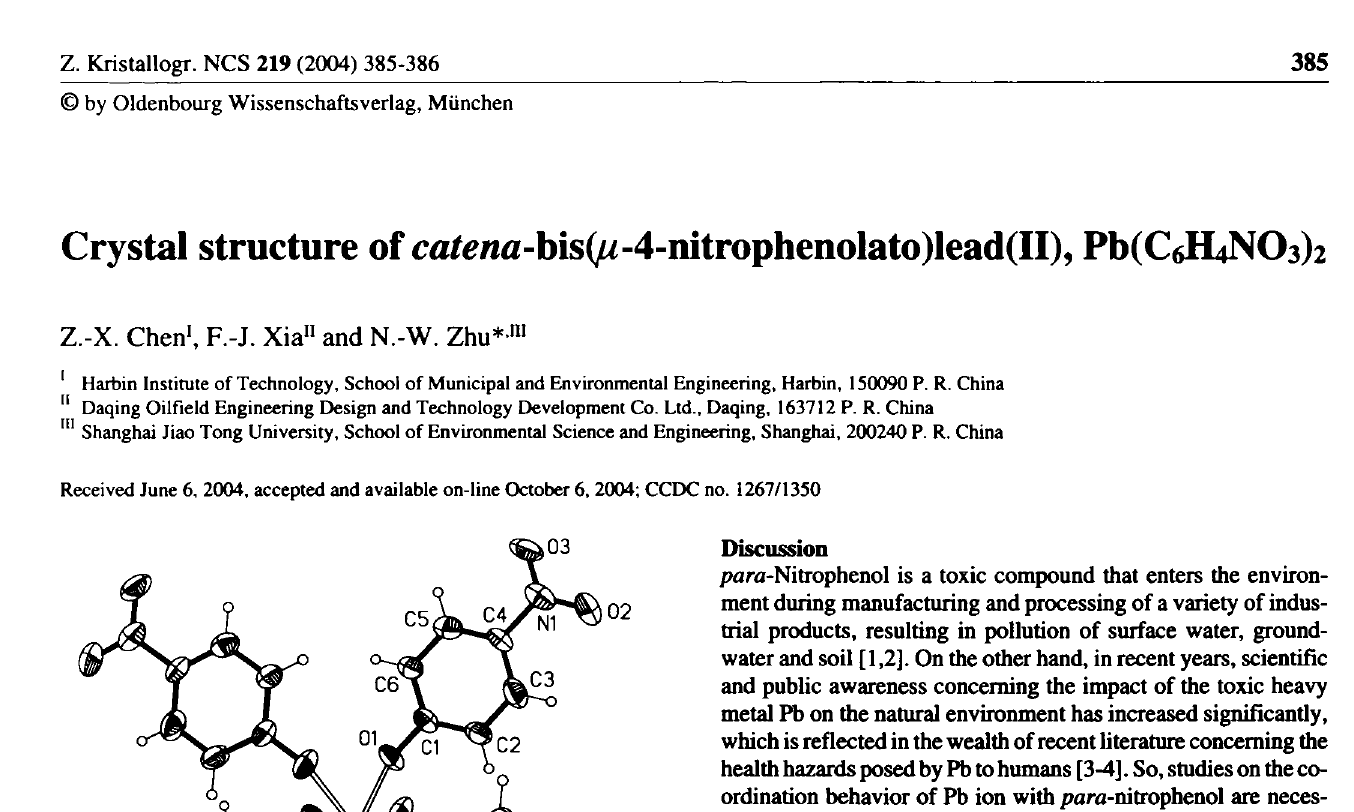
Table 1. Data collection and